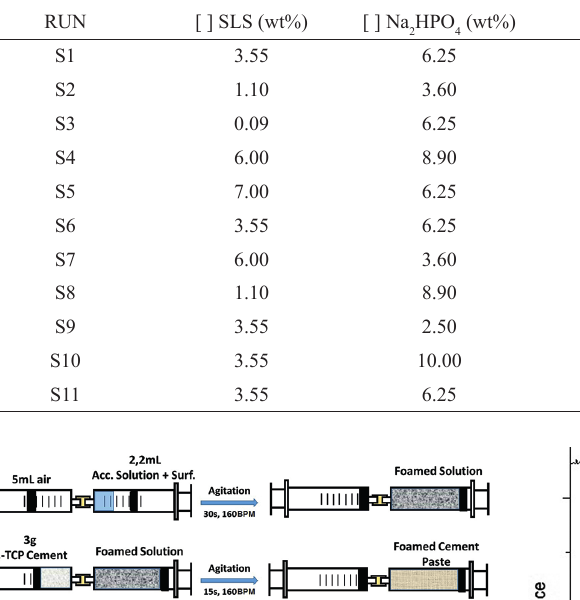
Sodium Lauryl Sulfate